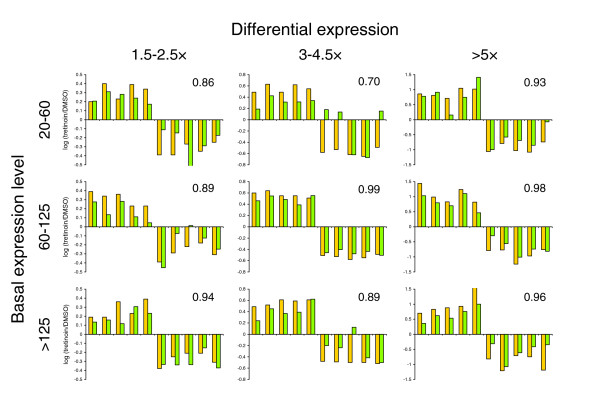
Performance in a representative gene space. Total RNA from HL60 cells treated with tretinoin or vehicle (DMSO) alone were analyzed by LMF in the space of 90 transcripts selected from microarray analysis of the same material. Plots depict log ratios of expression levels (tretinoin/DMSO) reported by both platforms for each transcript, in each of nine classes. Correlation coefficients of the log ratios between platforms within each class are shown. Yellow bars represent microarray findings and green bars LMF findings. Ratios were computed on the means of three parallel hybridizations of the pooled product from three amplification and labeling reactions (microarray) or 10 parallel amplification and hybridization procedures (LMF) for each condition. Basal expression categories are 20-60 (low), 60-125 (moderate), and >125 (high). Differential expression categories are 1.5-2.5× (low), 3-4.5× (moderate), and >5× (high). DMSO, dimethyl sulfoxide.